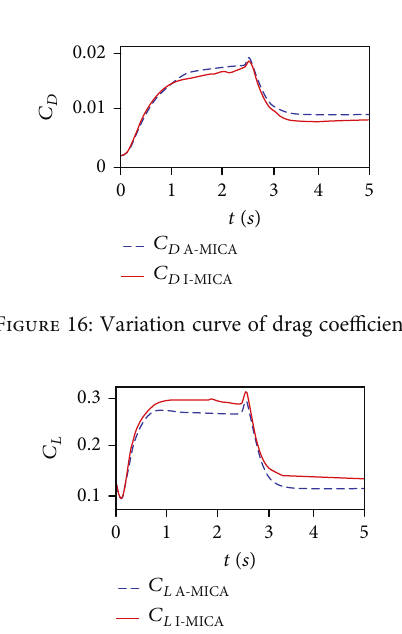
Figure 15: Statistics of the average de fl ection of the control surface.